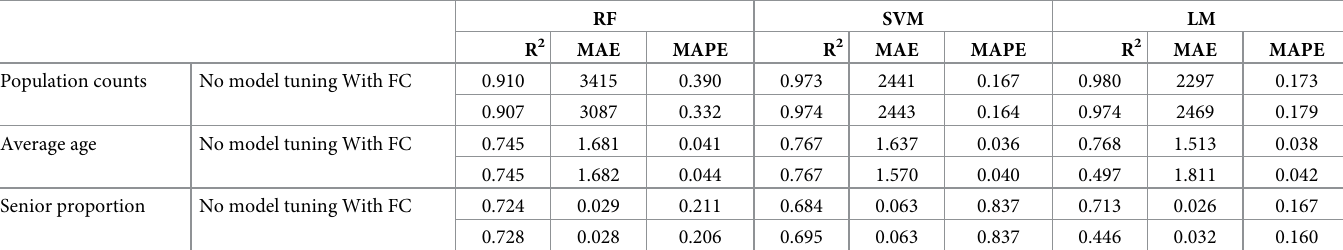
Table 2. Overview of the performance of the different combinations of the developed regression models to estimate population counts and